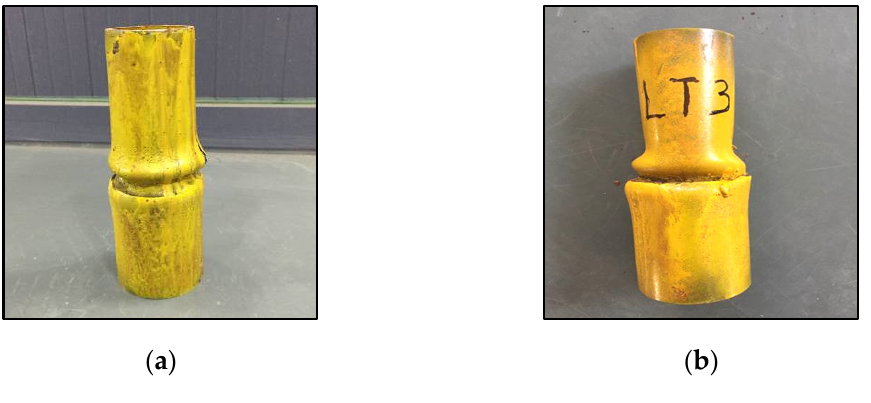
( b ) Figure 20. Finite element analysis of sleeve shear capacity: ( a ) Original data; ( b ) average values. Figure 21. Shear stress diagram of a sleeve.